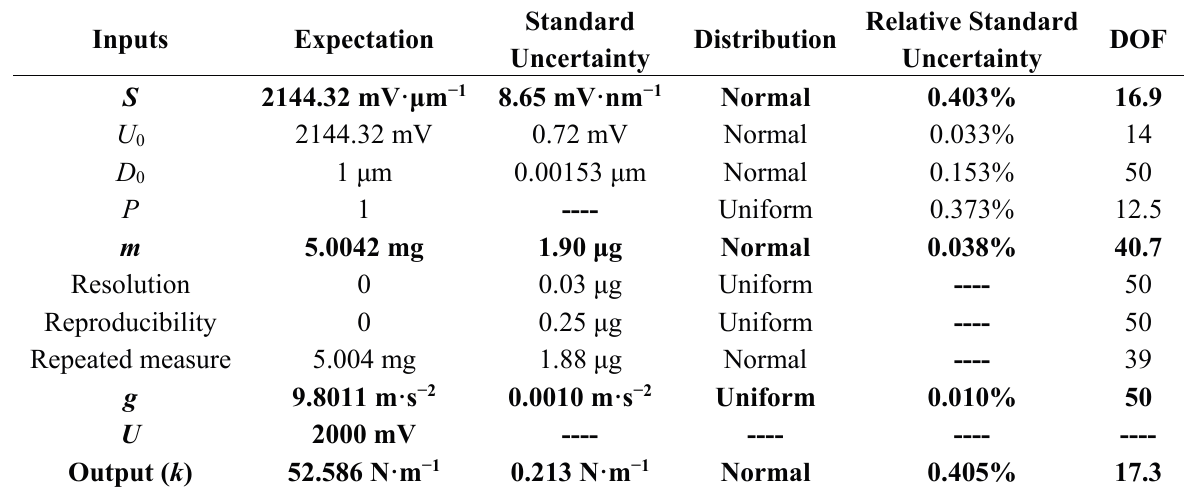
Table 3. Uncertainty estimation results of NSC15_F#1